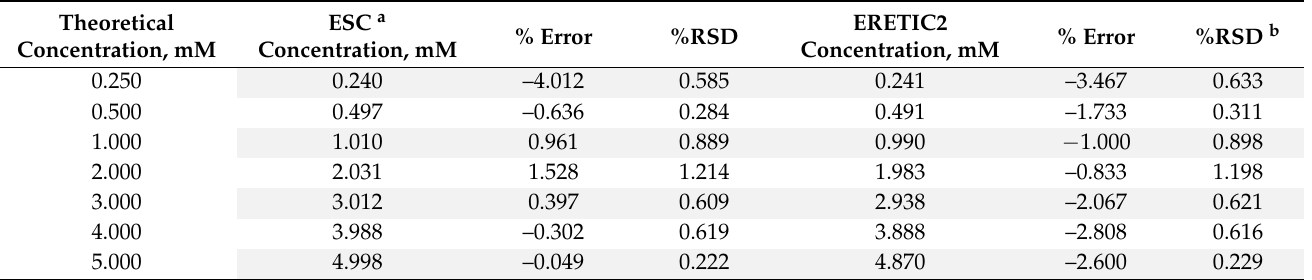
Table 4. Intraday precision and accuracy results (average results given, n = 3) for external standard and ERETIC2 methods.